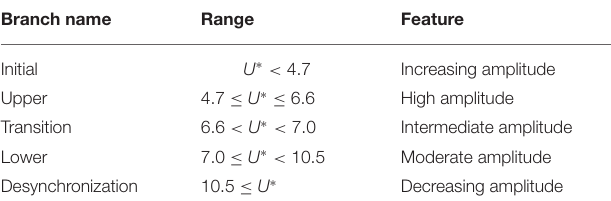
TABLE 1 | VIV branches obtained from the variation of the response amplitude with reduced velocity.